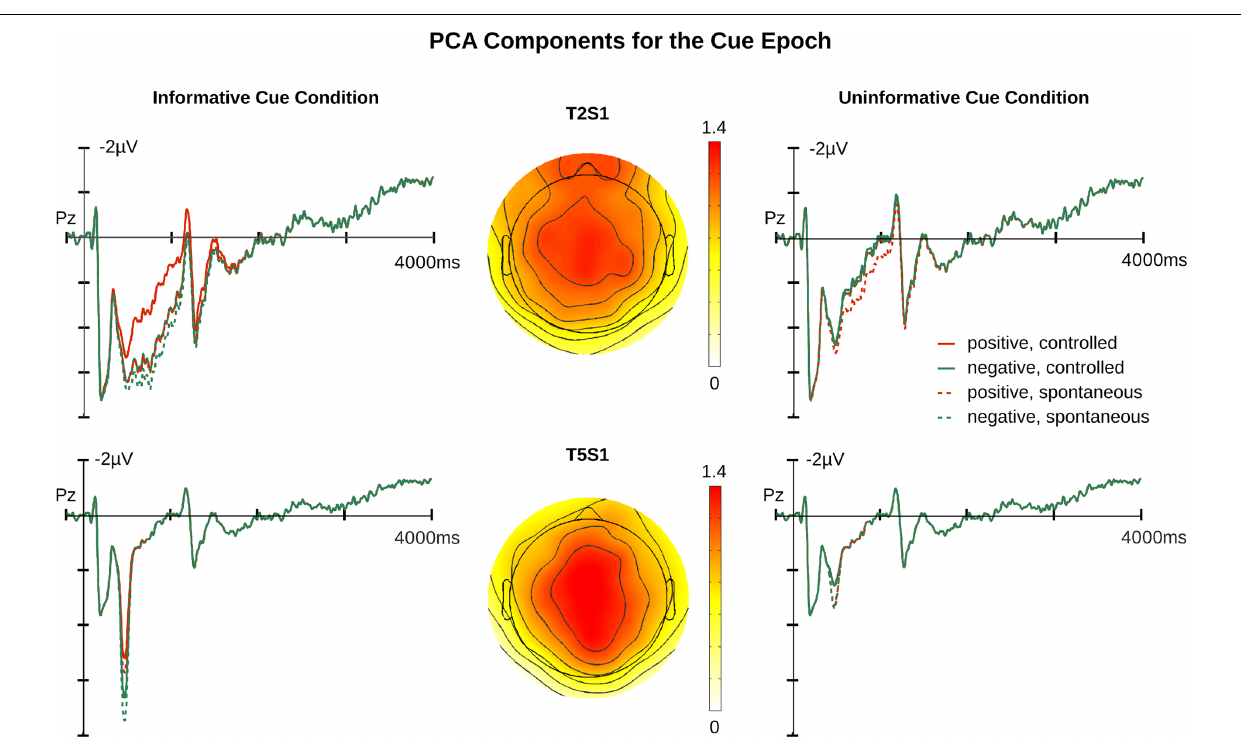
Frontiers in Human Neuroscience |